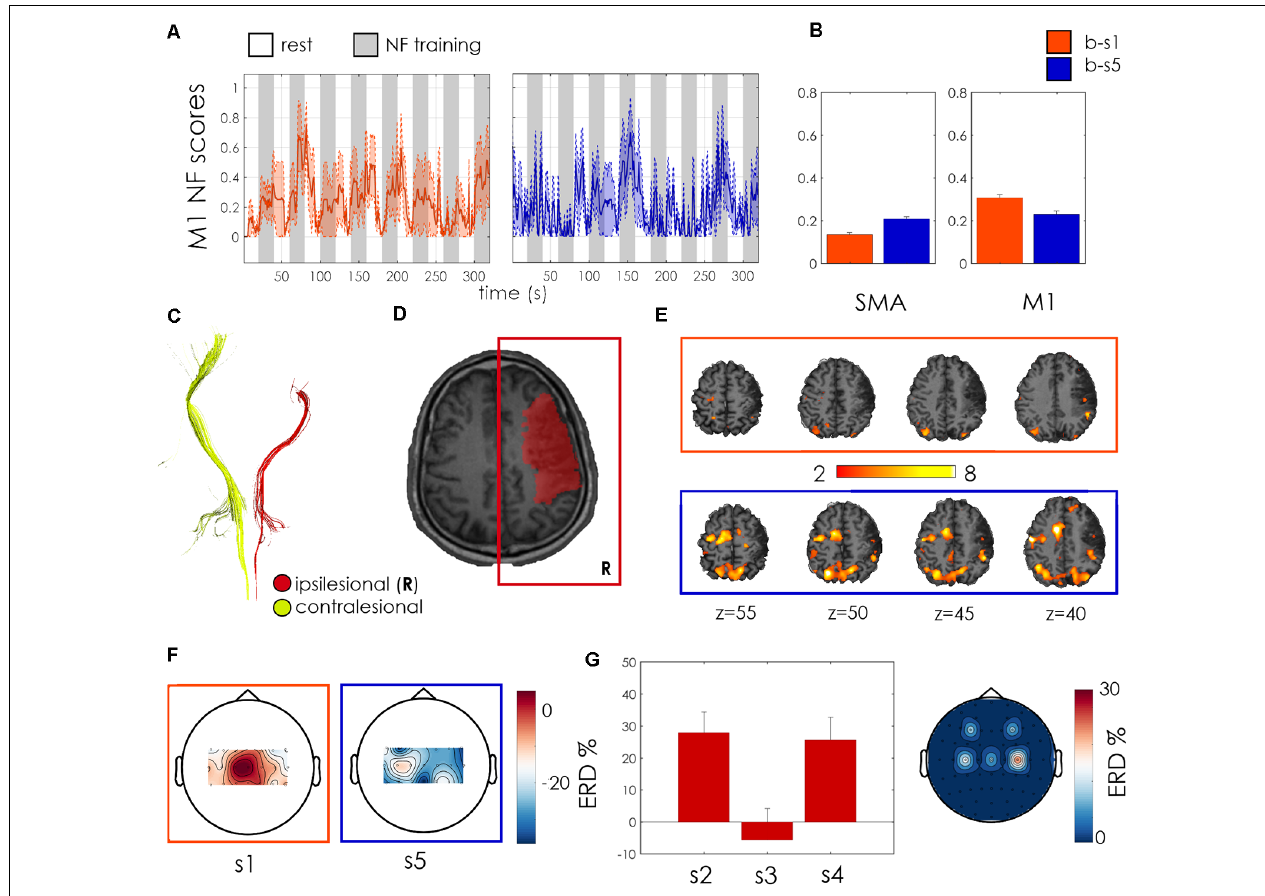
FIGURE 7 | Patient 04 outcome measures. Legend as for Figure 4